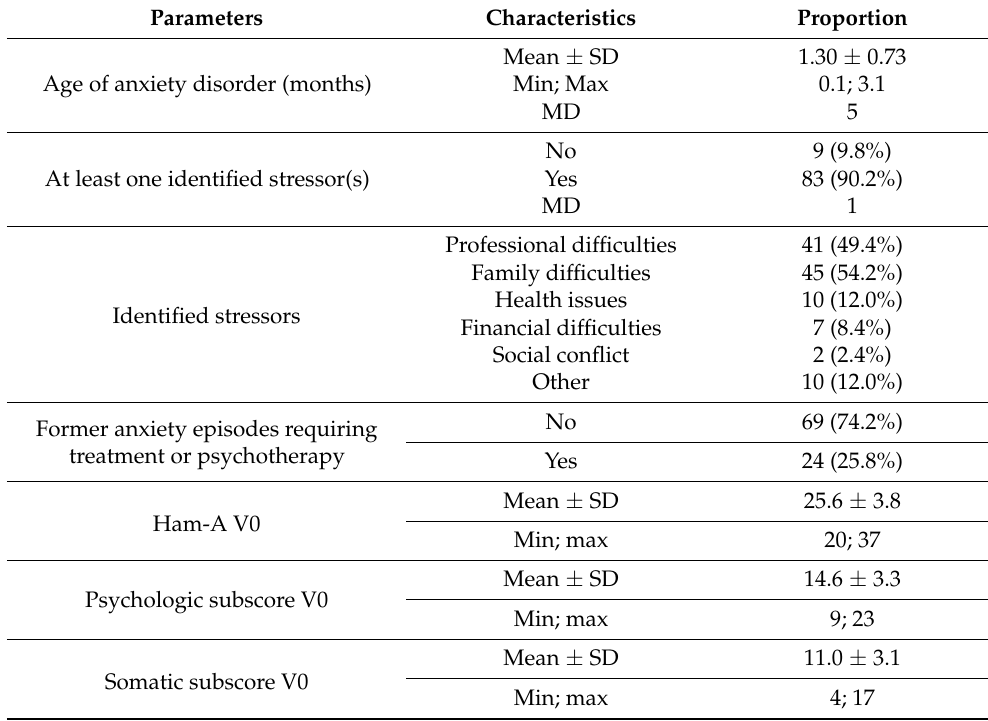
Table 2. Description of medical history of anxiety disorders. Parameters